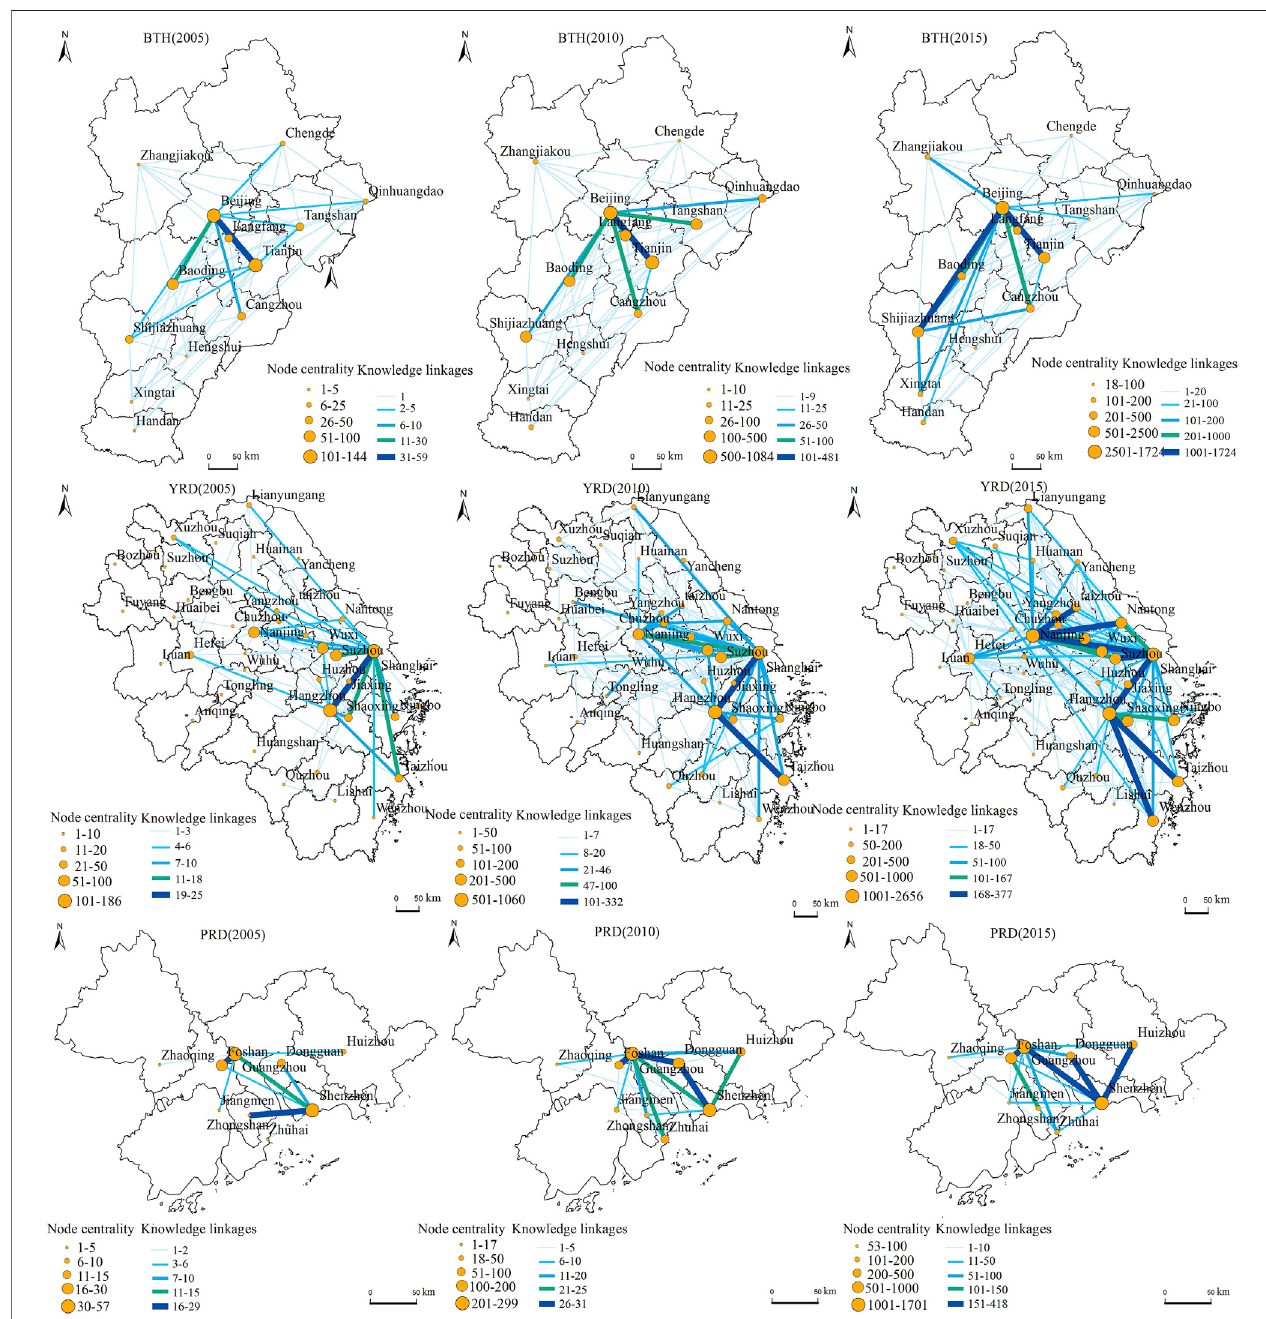
FIGURE 2 | The innovation network evolution of three